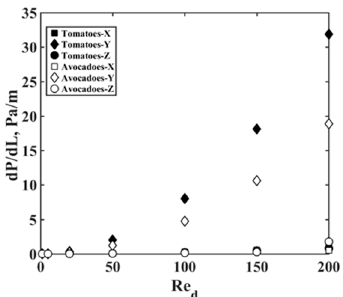
Figure 9. Plot of pressure drop as a function of the Reynolds number over the range of Reynolds numbers considered.